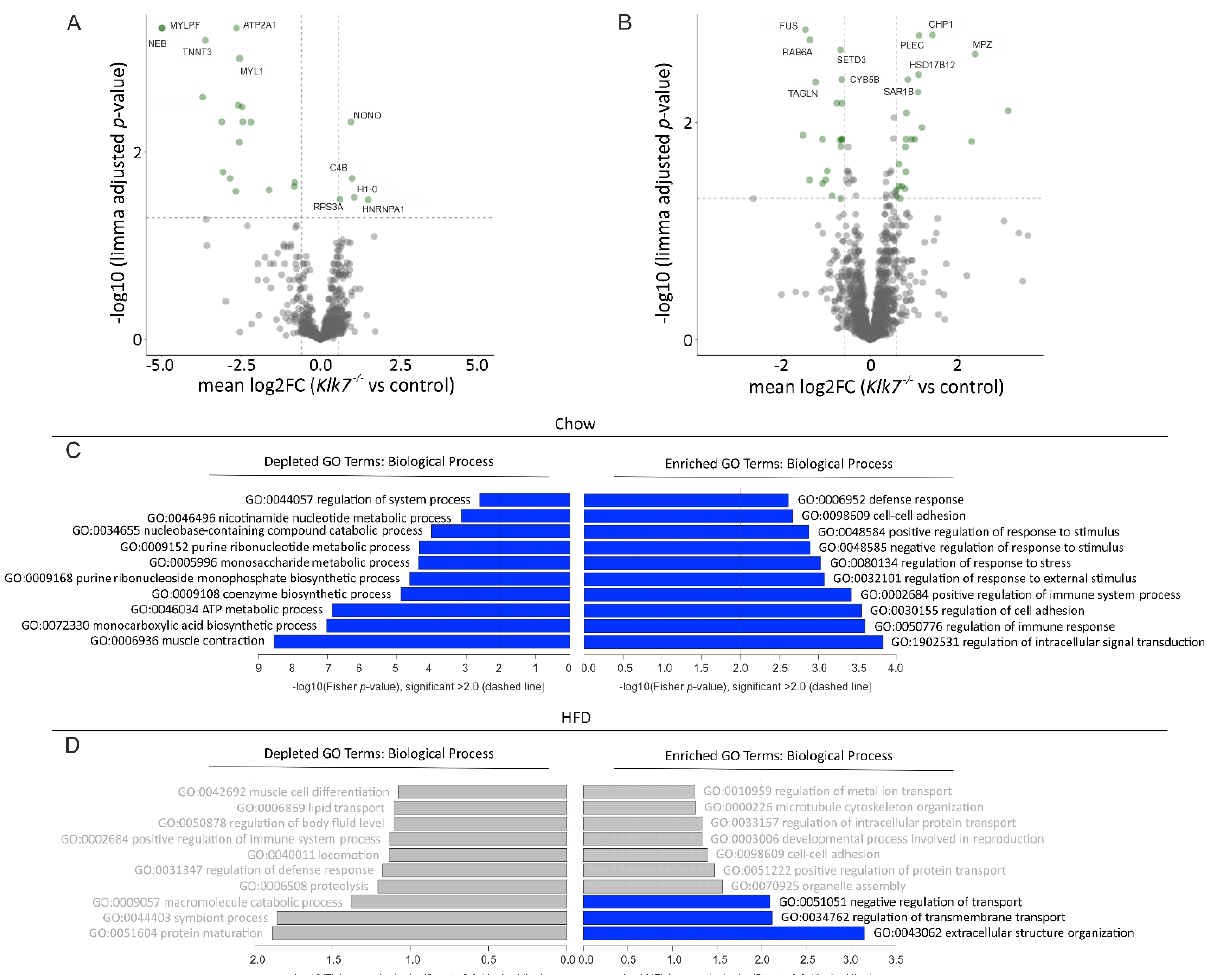
Figure 7. Analysis of proteome expression changes induced in iWAT of AT-specific Klk7 −/− mice. ( A , B ) Volcano plots of differentially expressed proteins in iWAT of AT Klk7 −/− mice under chow ( A ) and HFD ( B ) conditions. Protein expression data in the volcano plot are displayed as log2 fold change (FC) versus the log10 of the limma adjusted p -value. Proteins with significant differences in expression compared to controls are shown in green. Thresholds are shown as dashed lines. The top five differentially expressed genes (sorted by log-odds) are labelled with corresponding gene symbols. ( C , D ) Enriched GO terms related to biological processes in chow- (upper panel) and HFD-fed (lower panel) animals. Vertical bars represent the GO terms; the horizontal axis indicates −log10 ( p -value). Significantly enriched GO terms are labelled in blue.